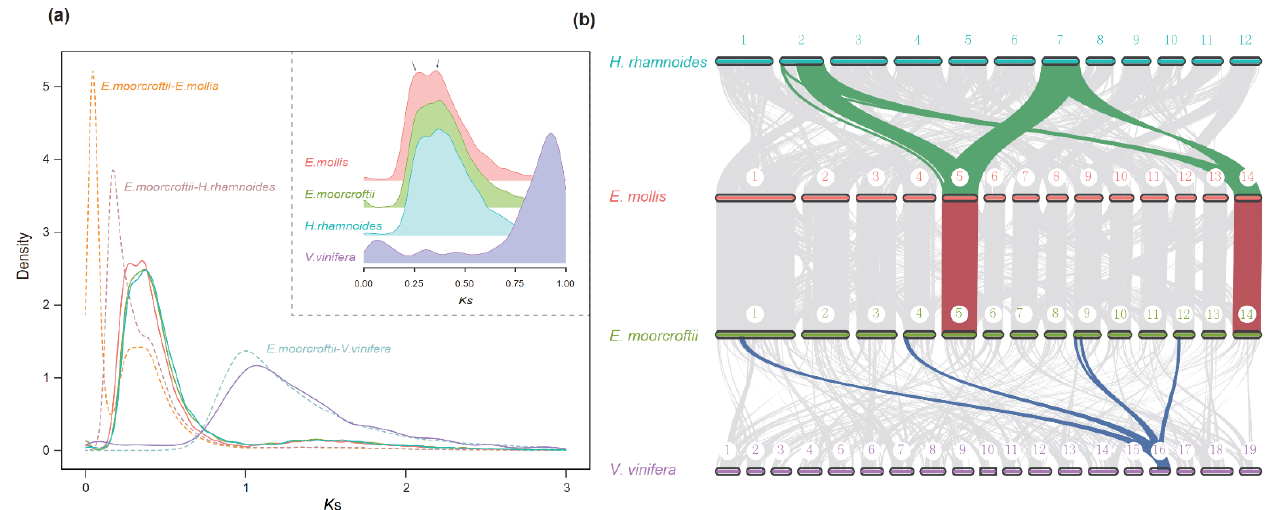
Figure 3. Integrating K s and synteny analyses reveal two successive WGD events in E. moorcroftii . ( a ) The distributions of K S of paralogous gene pairs of E. mollis (pink line), E. moorcroftii (green line), H. rhamnoides (blue line), and V. vinifera (purple line). The dashed lines represent K S distributions related to the species divergence of the corresponding species pairs. ( b ) Macro-syntenic comparisons among three Elaeagnaceae species and V. vinifera .